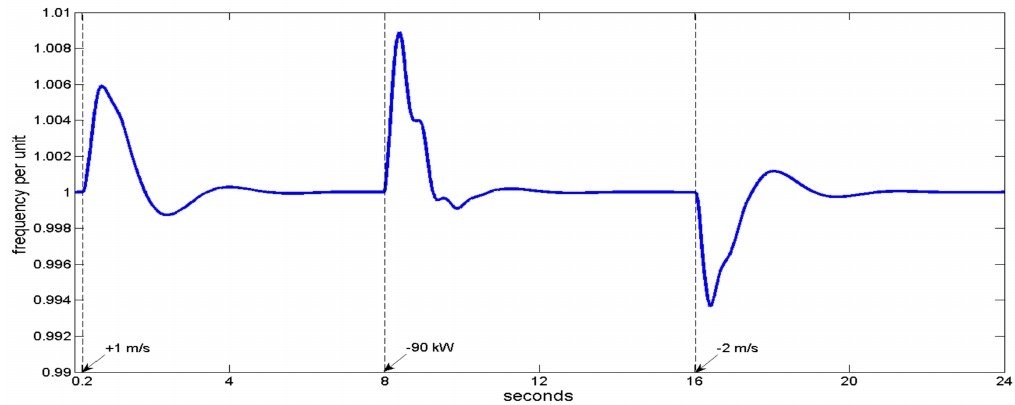
Figure 7. WDIM frequency